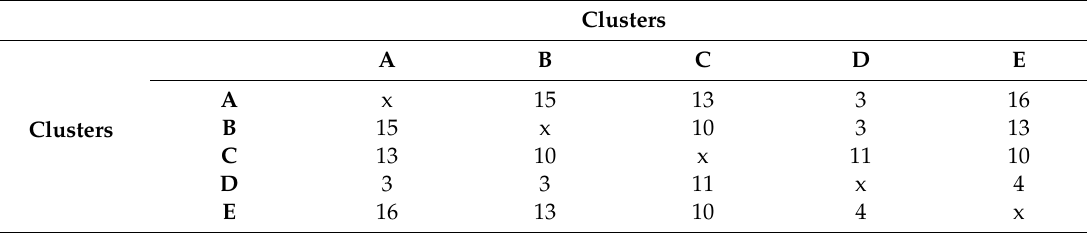
Table 6. A matrix showing the scale of similarity between the clusters (the cells show the number of cases in which a given cluster formed a homogenous group with other clusters—LSD test). Clusters A B Clusters